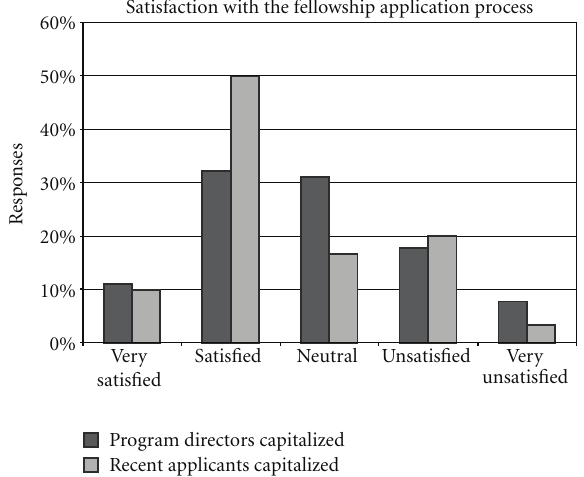
Figure 7: Column chart comparing satisfaction with the fellowship application and selection process between program directors and recent